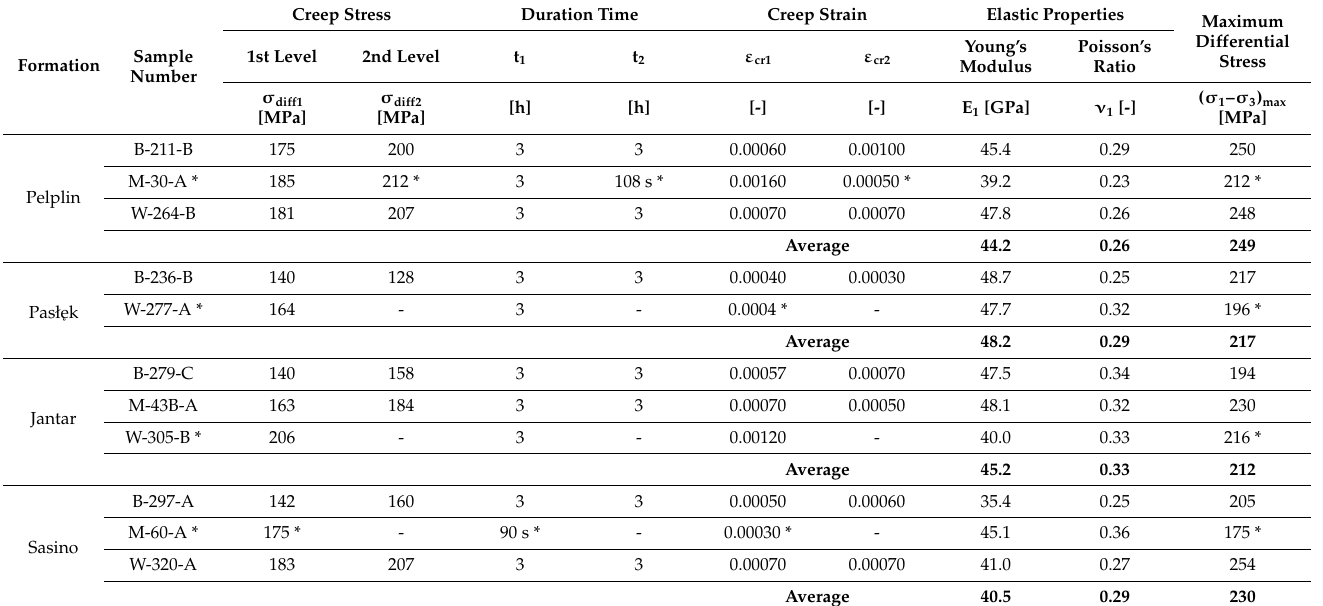
Figure 8. Relationship between axial strain, lateral strain, and differential stress and time in the brittle creep test for sample M-43-A. Table 2. Conditions of the performed analyses and results obtained during brittle creep tests for all analysed samples from the siltstone-claystone formations.